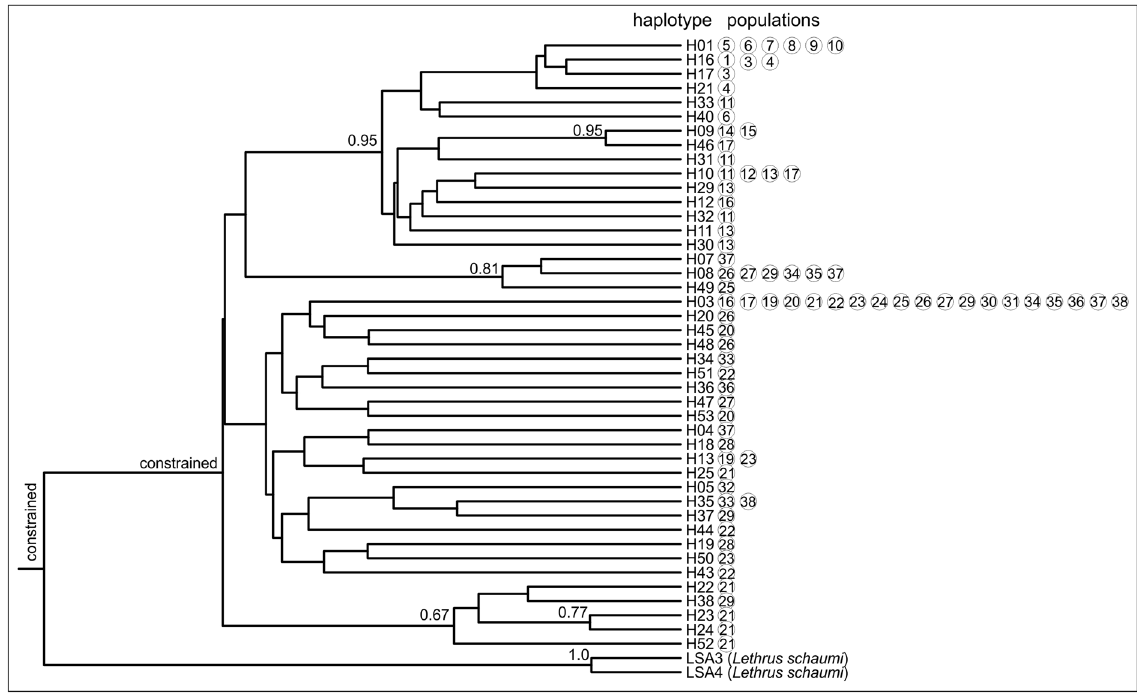
Figure 4. Maximum credibility phylogenetic tree resulting from the Bayesian approximation of evolutionary relationships of mitochondrial COI haplotypes of the studied Lethrus apterus populations (identified by their number as given in Table 1.) as estimated by the software BEAST. Haplotypes of L. schaumii are included as outgroup. The sister relationship of L. schaumii and L. apterus was constrained, as was the monophyly of samples of L. apterus . Bayesian posterior probability (Bpp) values of clade credibility is printed next to each branch receiving Bpp > 0.65 cally significant (bs ≥ 81%) grouping was formed by samples from the Bulgarian Plain (populations 20, 21 and 22—“Knezha”, “Ovcha Mogila” and “Gorna Studena”, respectively), and populations from the eastern periphery of the distribution range in Russia close to River Don (populations 31, 32, 33 and 35—“Liski”, “Rossoshki”, “Don Motorway” and “Gavrilsk”, respectively) that are significantly separated (bs = 98%). Additional groupings were formed by geographically close populations (e.g., populations 1 and 2—“Vizslás” and “Dorogháza”; populations 9 and 10—“Gömörszőlős” and “Ragály”; populations 17 and 18—“Dombegyháza” and “Baraczháza”, respec- tively). Large rivers were found to be important indicators of significant separations. The populations from the eastern shore of River Dnieper are separated significantly (bs = 99%) on the NJ-tree (Fig. 5) from those on the west bank; the populations on the Bulgarian Plain are separated from the populations of the Pontic Steppes north of River Danube by bs = 81%; and the Serbian population on the southern bank of River Danube is separated from other Pannonian Steppe populations with a similarly high support (bs = 84%); populations on the Great Hungarian Plain are separated from the populations of the Hungarian Middle Range north of River Tisza with high sup- port (bs = 82%). Interestingly, the separation of the populations from the western part of the Hungarian Middle Range, which is split into two sides by River Danube, is less pronounced (bs = 61%). Similarly, River Don causes apparently no separation at the very eastern margin of the area. The Geneland clustering analysis identified in all five runs the same, 21 most probable genetic clusters that correspond to the grouping based on allelic frequencies (Fig. 5). Interestingly, Geneland found eight genetic clusters (Fig. 5: clusters 15, 9, 1, 13, 18, 4, 7, 14) in the Hungarian Middle Range (across ca 5000 km 2 area), whereas only four were found on the vast area (ca 90,000 km 2 ) of the Pontic Steppes east of River Dnieper (Fig. 5: clusters 2, 8, 16, 17). The genetic differentiation of the studied populations was visualised in a Principal Coordinate Analysis (Fig. 6). The first axis—that separated the populations along an east-to-west geographic gradient—accounted for a remarkable 65.2% of total variability. The genetically most differentiated population group was formed by the Russian populations at the eastern edge of the distribution range close to River Don (populations 31–38 on Fig. 1). Also differentiated are other populations east of River Dnieper (populations 28–30 on Fig. 1). Some differentiated populations showed a remarkable divergence from all the rest, e.g. population “Balatonkenese” (population 12 on Fig. 1) or “Lgov” (population 30 on Fig. 1). Otherwise, the genetic differentiation reflects geography (cf. Fig. 1). In line with this pattern, we found a very strong isolation-by-distance (IBD) pattern in our dataset: the genetic distance matrix showed a very significant correlation with the pairwise geographic distances (Mantel-test, p < 0.001; Fig. 7).